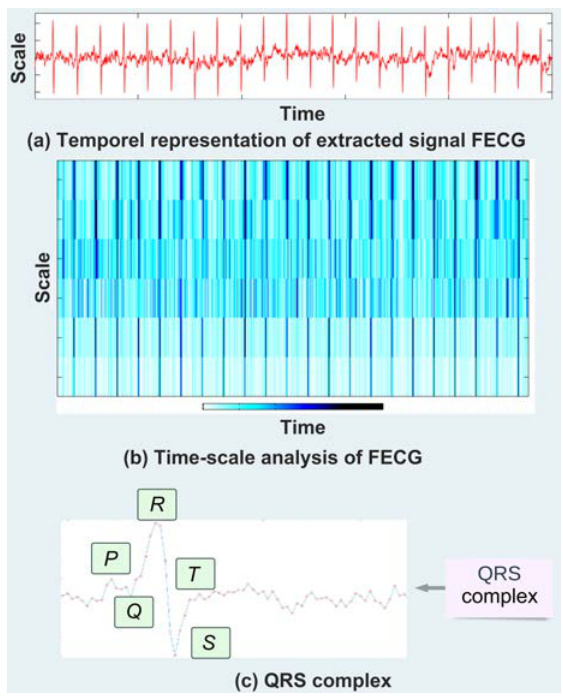
Fig. 16 Extracted signal